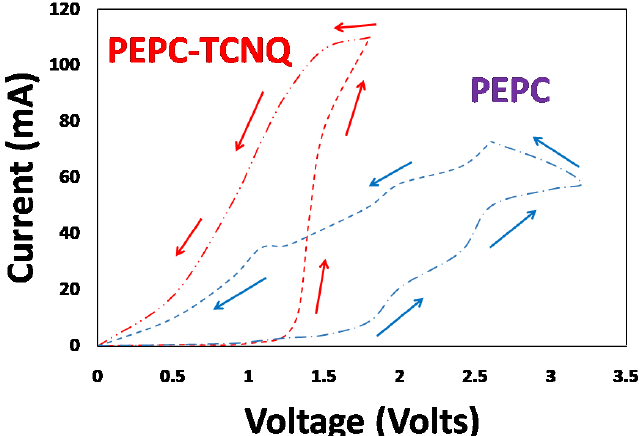
Figure 3. Current–voltage characteristics of Cu/PEPC/Ag and Cu/PEPC-TCNQ/Ag diodes mea- sured at room temperature, showing a typical memory hysteresis curve for both devices. The sweeping path in the figure is shown by the arrow directions.